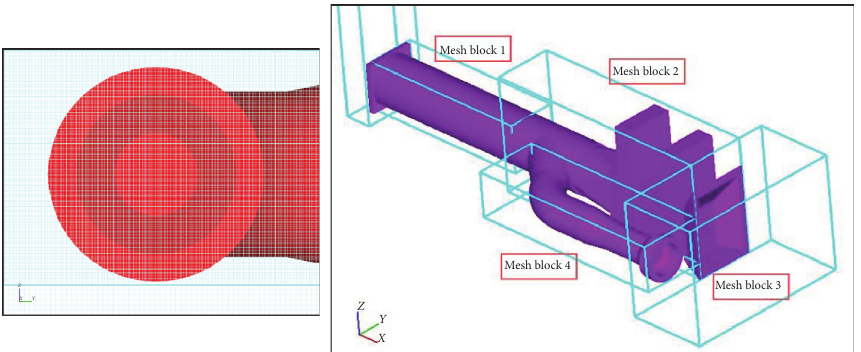
Figure 5: Numerical model’s gridding and meshing blocks for bottom outlets and branch in Flow-3D numerical